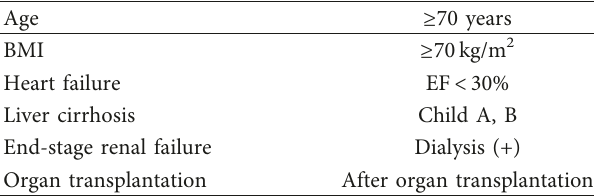
Table 1: Definition of high